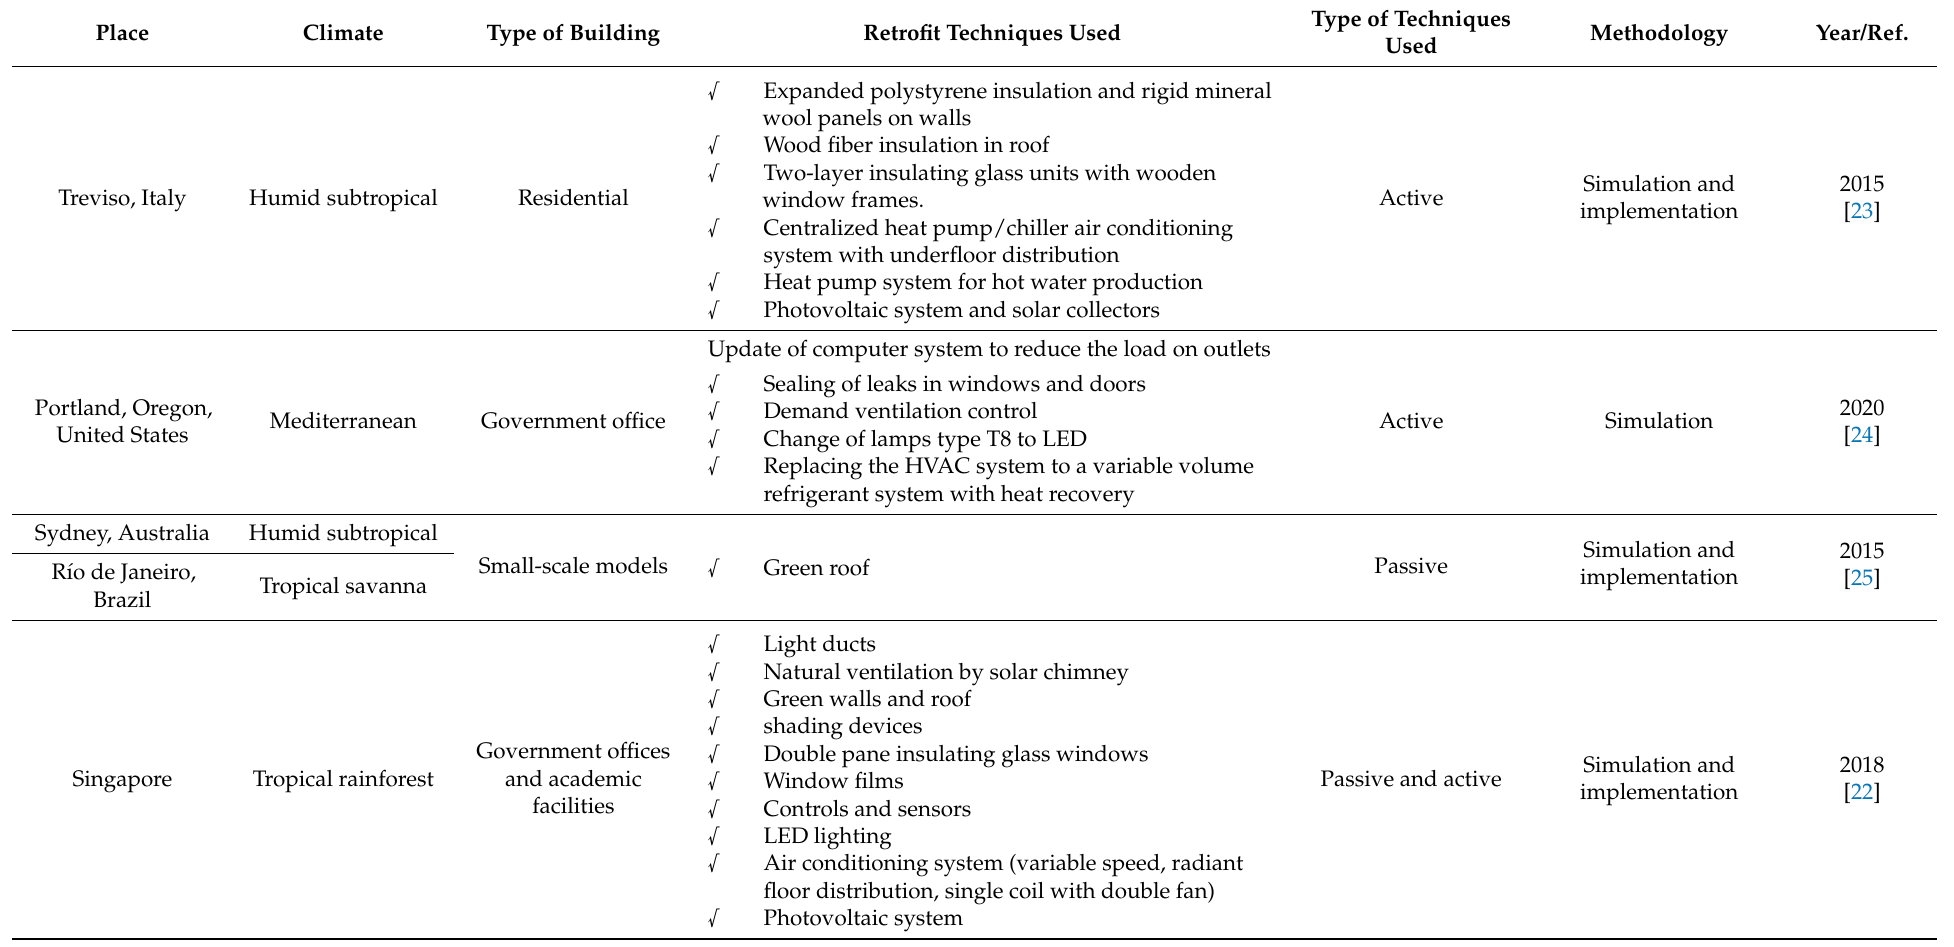
Table 1. Summary of the state of the art of the different studies according to the place, climate, type of building, renovation techniques used and